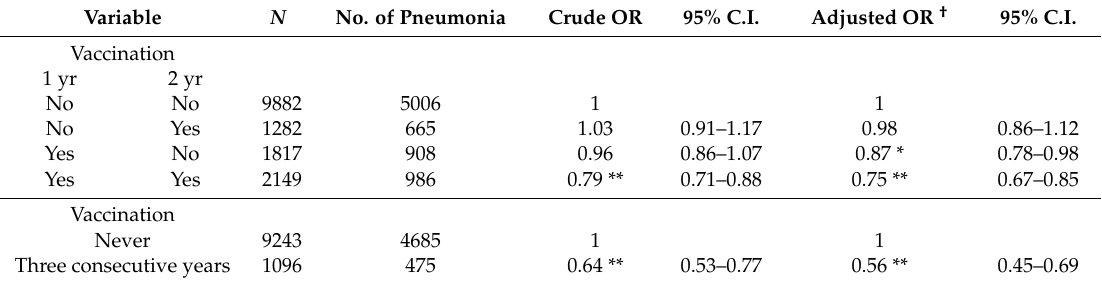
Table 3. Conditional logistic regression of the frequency of receiving an influenza vaccination.